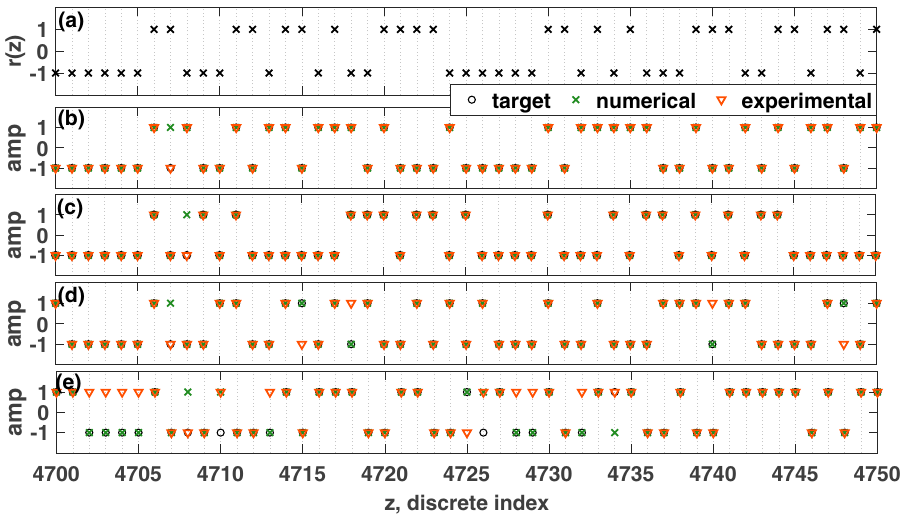
Figure 7. Comparison of the performance of the PRC for parity tasks. ( a ) Discrete input function, r ( z ). ( b ) 2nd order parity task. Information metric: R exp = 1.00 , R sim = 0.98 . ( c ) 3rd order parity task. Information metric: R exp = 1.00 , R sim = 0.98 . ( d ) 4th order parity task. Information metric: R exp = 0.68 , R sim = 0.93 . ( e ) 5th order parity task. Information metric: R exp = 0.31 , R sim = 0.74 . Parameters were set such that: V µ = µ = 5 , A = 0.5 , = ω 0 = 40 π , T p = 0.1 seconds, N = 1000 nodes, φ = π/ 3 rad, σ = 15 , β = 1.0 , and a total � = 40 π rad/s, V ω 0 time of 5000 T p = 500 seconds (only a portion of the discrete prediction is shown).